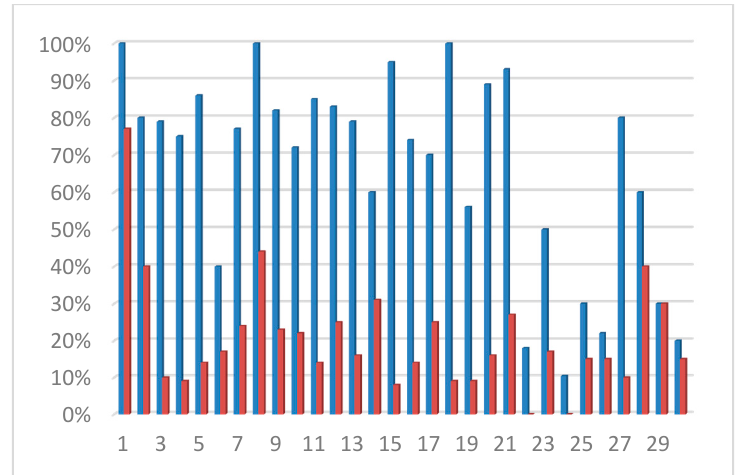
Figure 7. Average probing depth in millimeters before (T1) and after treatment (T3). Patients from 1 to 10 were included in group A, from 11 to 20 were in group B and from 21 to 30 were in group C. The total average was 1.83 mm. Group A’s average decrease was 2.14 mm, group B’s average decrease was 2.36 mm, and group C’s average decrease was 0.99 mm.